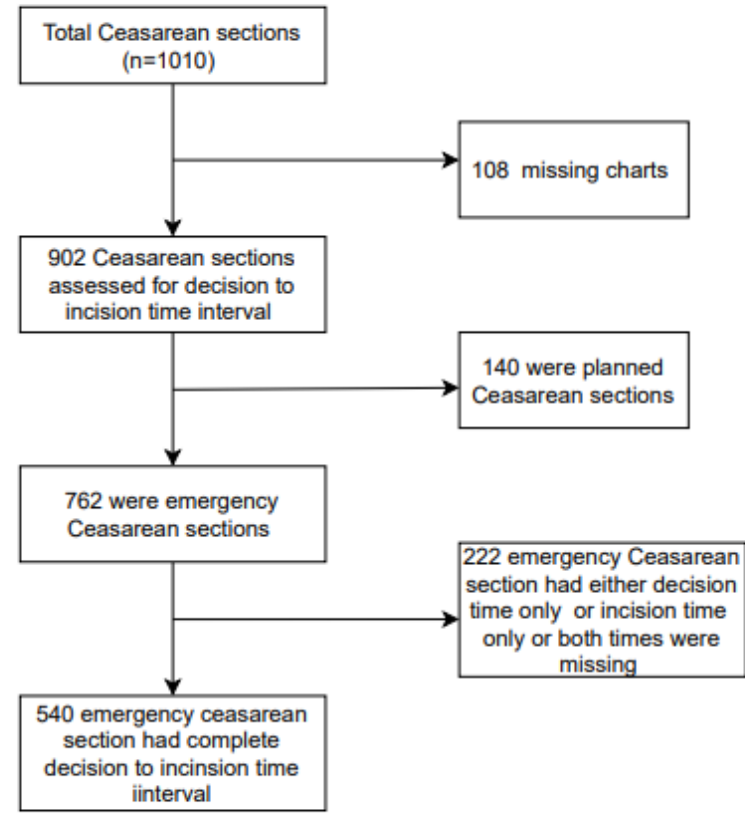
Figure 1. Cesarean sections at Koidu Government Hospital between October 2016 and September 2018.